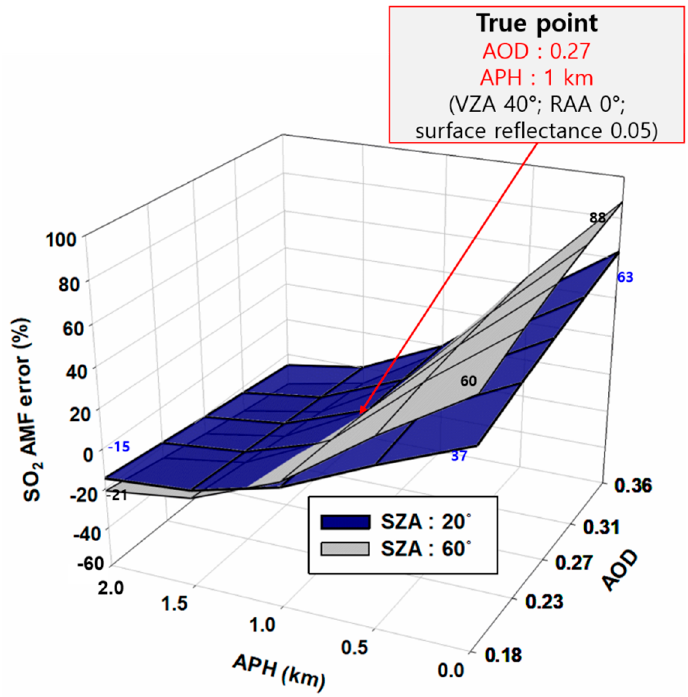
Figure 10. Percent difference in PBL SO 2 AMF calculated with various AOD, APH, and SZA values and compared with a ‘true’ AMF that is calculated for AOD = 0.27, APH = 1 km, and SZA = 20° and 60° (VZA = 40°; RAA = 0°; surface reflectance = 0.05; O 3 VCD = 275 DU; wavelength = 318 nm; aerosol type = sulfate). Table 2. AOD and surface reflectance uncertainty.